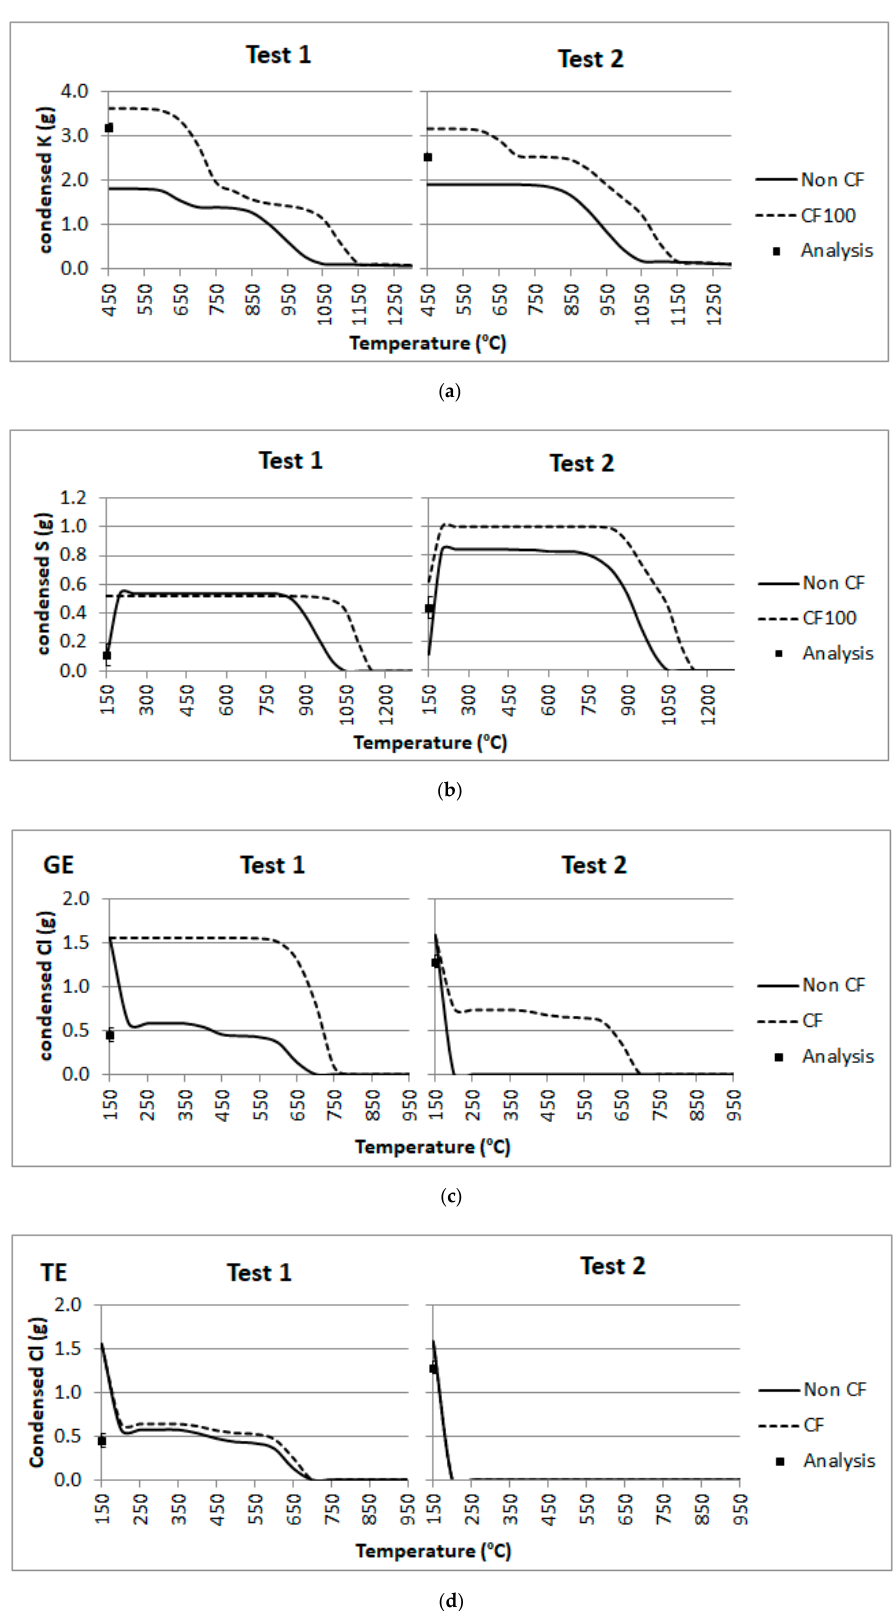
Figure 6. Evolution with temperatures of condensed K ( a ), S ( b ), and Cl ( c ), as predicted by the GE entrainment model, and condensed Cl according to the TE model ( d ), considering (CF100) and disregarding (Non CF) chemical fractionation. Black squares correspond to the g of the element per kg of biomass obtained from the elemental analyses of fly ash samples taken onsite at the plant. Both Cl and K show similar behaviors in Test 1. However, the values predicted for Test 2 are in general well below the analytical results, even in the best case, obtained in the 200–600 °C temperature range using either GE or IE models and CF100 chemical fractionation. Cl predicted values using the TE model are affected by the lower temperatures applied on the grate, not showing differences between the different chemical fractionation cases considered. As for S, the theoretical SO 2 concentration has been calculated from the S content results obtained after solving the EQ3 stage over the gas volume resulting from the calculation of the EQ4 stage. Condensations of inorganic elements are considered negligible in comparison to the total volumetric flow rate of the flue gas in the different stages. These values have been compared to the empirical measurements obtained onsite in Figure 7. The 100% value represents the average of the on-site measurement at the stack for each campaign, while dotted lines represent the minimum and the maximum values obtained from the chemical analyses. Again, the results provided by the GE and IE models are, in general, similar. However, when the No-CF and CF110 cases are considered, notable differences arise that are in the order of the analytical uncertainty. As for the TE model (not shown), once again, no differences between case studies are found, showing results that match those of the GE and IE models when no chemical fractionation is applied.